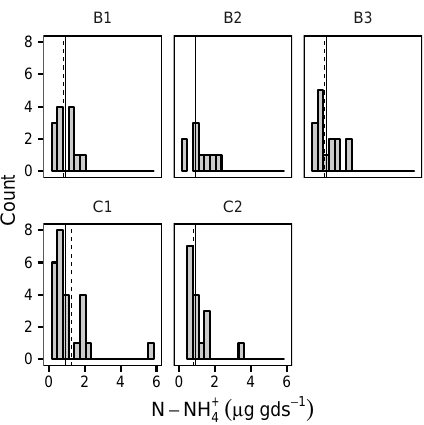
Figure 6. Mean posterior estimates for parameters predicting pool sizes of NH + and NO − . Parameters are days since fire (DSF), soil 4 3 pH, soil moisture (SM), soil organic matter (SOM), and substrate availability (i.e. NH + reported per gram of dry soil, gds). Thin black 4 lines show 95%CI and thick lines show 50%CI. CI may be ob- scured by the mean point. For visual clarity, posterior distributions of site effects are not included here. See text for